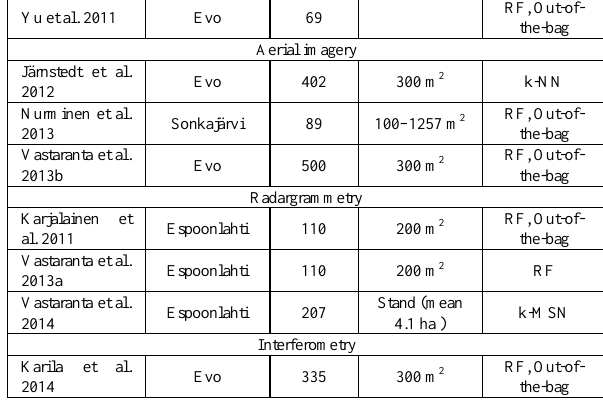
Table 1. Methods used in the estimation of forest inventory